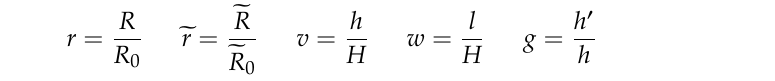
Figure 12. Percentage deviation between the resistance (cid:101) R calculated using Formula (36) for the real defect length and the resistance R calculated numerically.